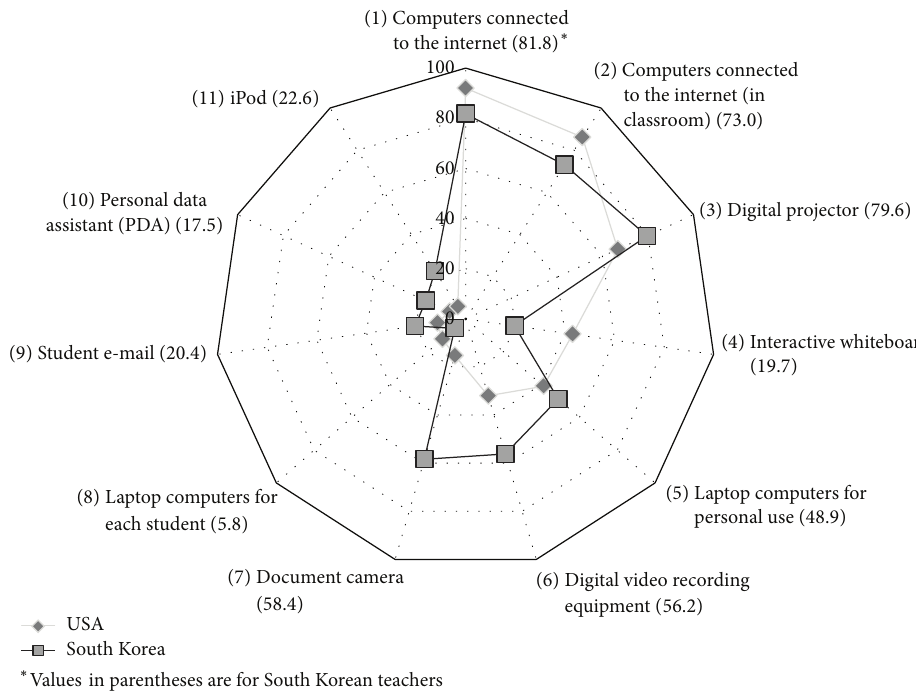
Figure 1: Percent of respondents indicating availability of technological tools and